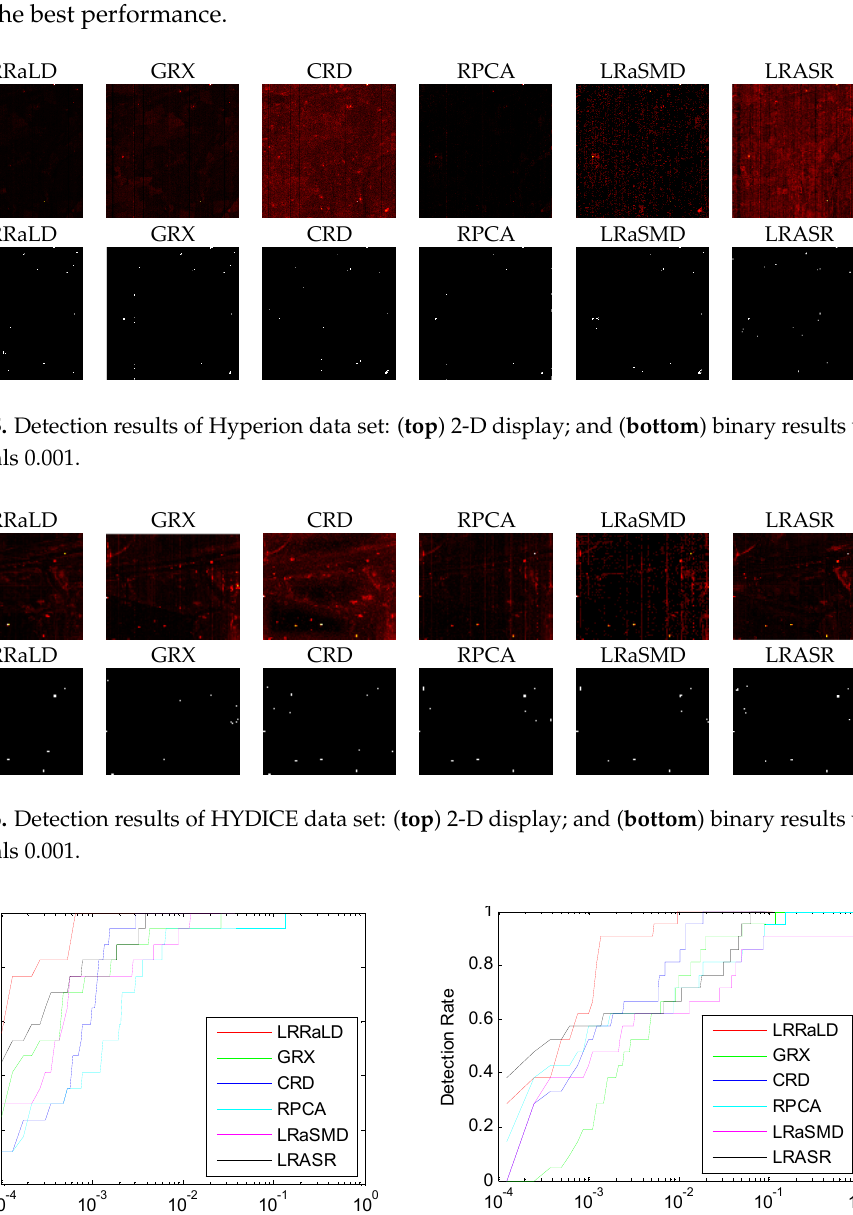
Figure 17. The ROC curves of the AD algorithms for the real data sets: ( a ) Hyperion data set; and ( b ) HYDICE data set.